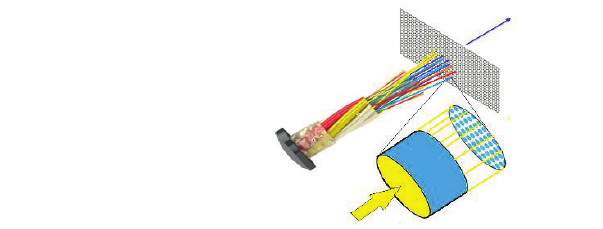
Fig. 2. Schematics of a multichannel all-optical switch (see details in the